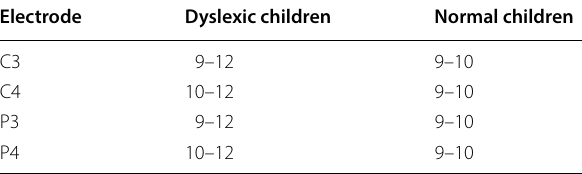
Table 2 Frequency range (Hz) of EEG for relaxed state [42] Electrode Dyslexic children